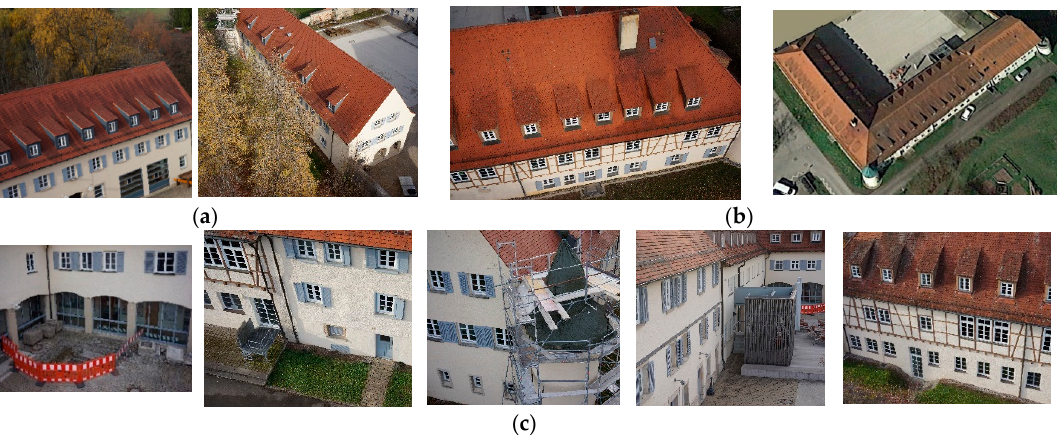
Figure 1. Study areas of ( a ) dataset 1 and, ( b ) dataset 2, which include ( c ) various windows, scaffolding, doors, and installations.